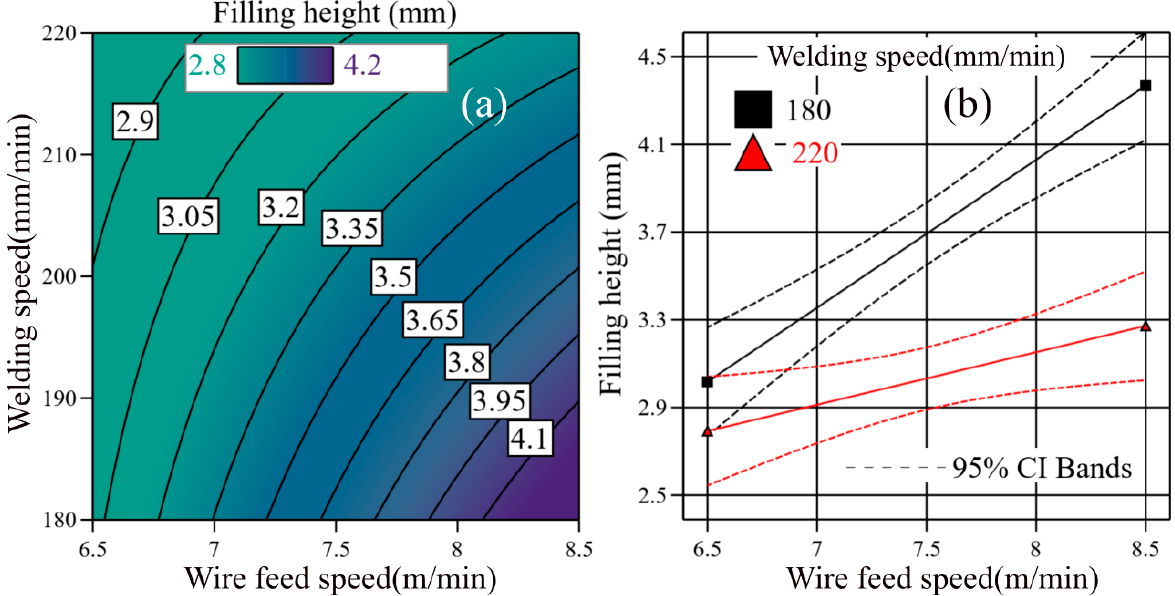
Figure 7. Height of filling passes in a couple of 12-millimeter-width grooves: ( a ) filling height obtained by the calculated models; ( b ) interaction of welding speed and wire feed speed on the filling height.